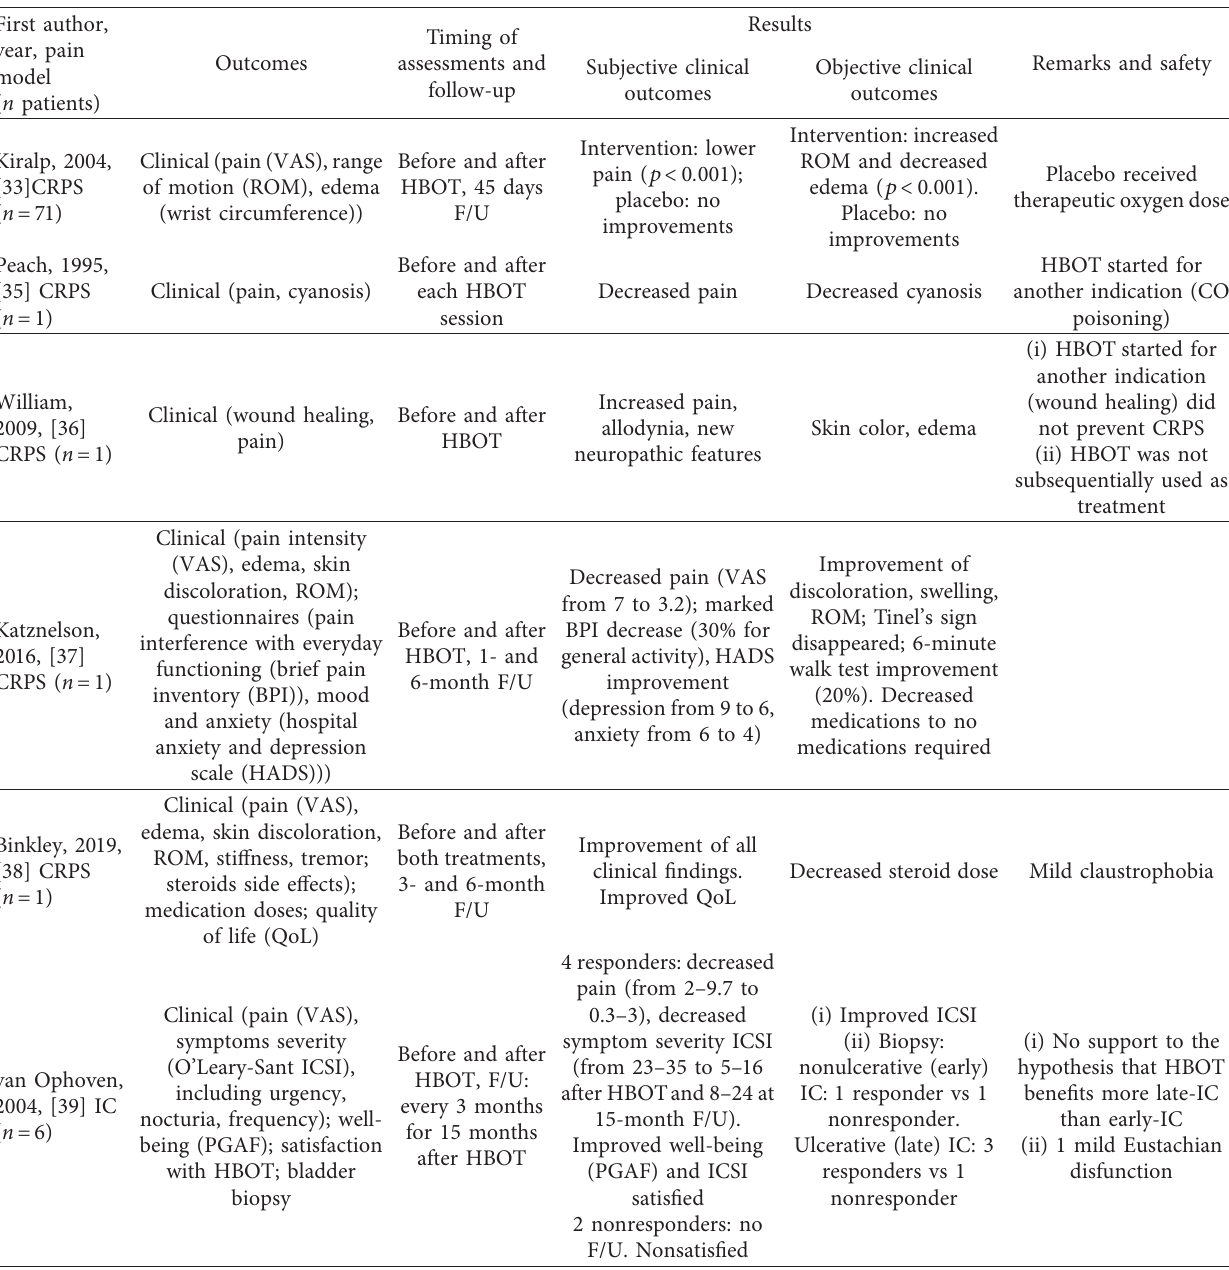
Table 7: Effect of HBOT on neuropathic pain patient